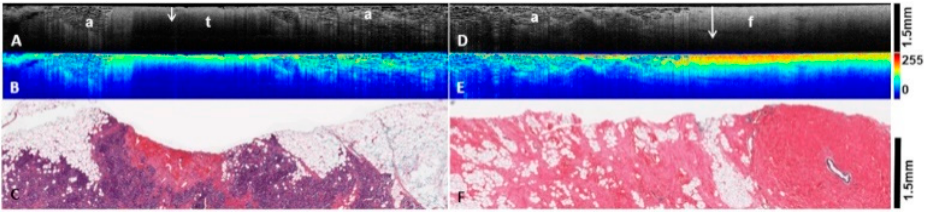
Figure 3. OCT image and heatmap analysis of invasive tumor (left column, A – C ) and normal breast tissue (right column, D – F ) from two different patients. ( A ): OCT B scans of invasive tumor (t) and surrounding adipose tissue (a). The tumors are characterized by reduced light PD (arrow) and dull texture. ( B ): Heatmap representation of corresponding OCT image above, showing lower levels of scatter by the tumor, manifested in mostly yellow hues. ( C ): Corresponding histology of invasive ductal carcinomas, high grade in 3C. ( D ): OCT B scans of normal breast tissue demonstrating fibrous stroma (f) and adipose tissue (a). The arrow shows increased light PD compared with tumors. ( E ): Heatmap representation of corresponding OCT image above. Note greater presence of warm colors and more homogenous light scattering pattern within benign fibrous tissue compared with tumors. ( F ): Corresponding histology of benign breast tissue.